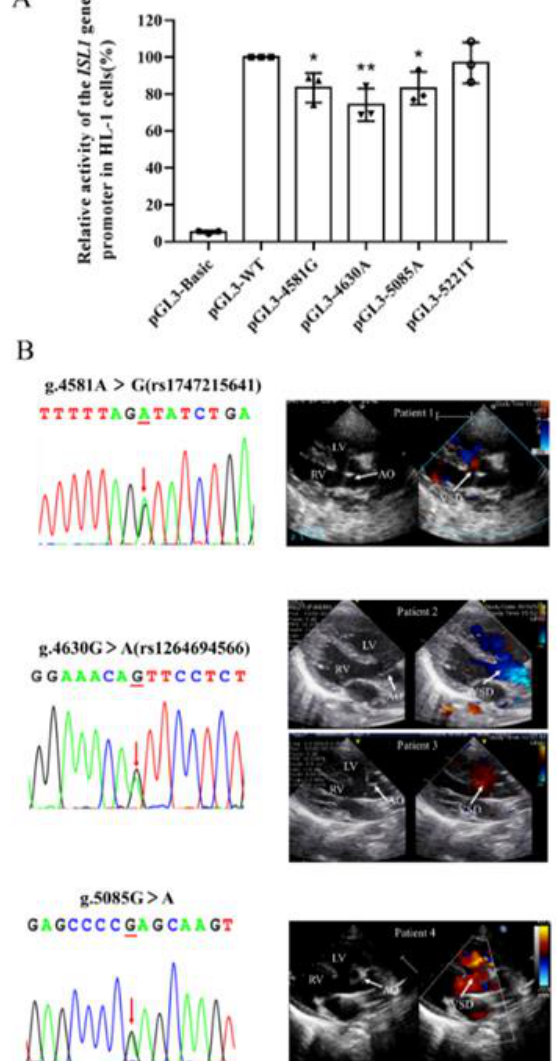
Figure 3. The result of the dual-luciferase reporter assay and the echocardiography of patients with these three variants. ( A ) Relative transcriptional activity of wild-type and variant-type ISL1 gene promoter in HL-1 cells. The negative control was empty vector pGL3-basic and the transcrip- tional activity of the wild-type ISL1 gene promoter was set as 100%. The quantitative data are presented as mean ± SD based on three independent experiments. * p < 0.05; ** p < 0.01. ( B ) The doppler echocardiography shows TOF in patients with variants of [g.4581A > G(rs1747215641), g.4630G > A(rs1264694566), g.5085G > A], showing the malalignment ventricular septal defect and aortic overriding. The ventricular septal defect is indicated with arrows. AO, aorta; RA, right atrium; RV, right ventricle; VSD, ventricular septal defect. To experimentally investigate whether the binding ability of transcription factor was affected by the variants identified only in TOF patients, EMSA was performed with wild- type or variant biotinylated oligonucleotides. The above three variants (4581G, 4630A, 5085A) markedly affected the binding of transcription factor in both HL-1 and HEK-293 cells, as shown in Figure 4 (presented with arrows). In addition, similar to the result in dual-luciferase reporter assay, the variant (5221T) did not affect the binding of transcription factor (data not